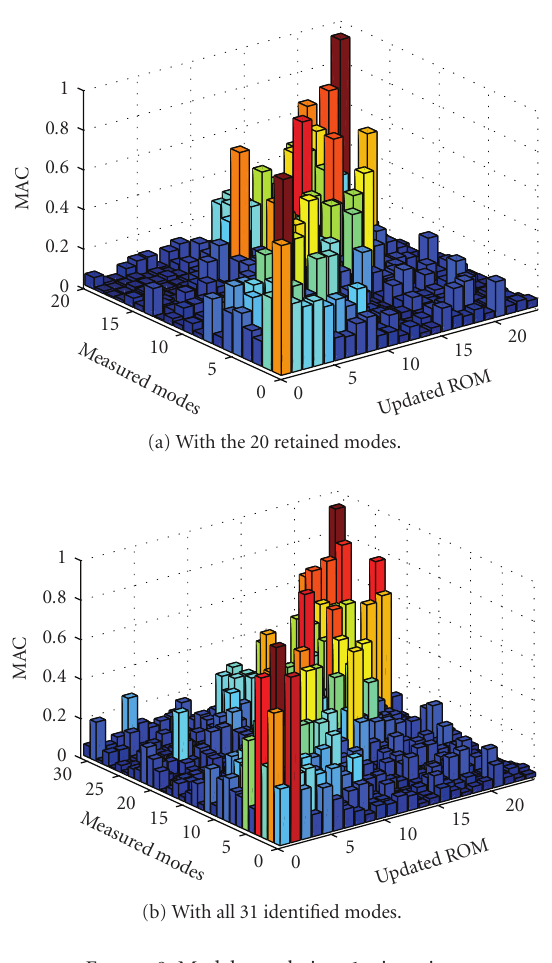
Figure 8: Modal correlation: 1st